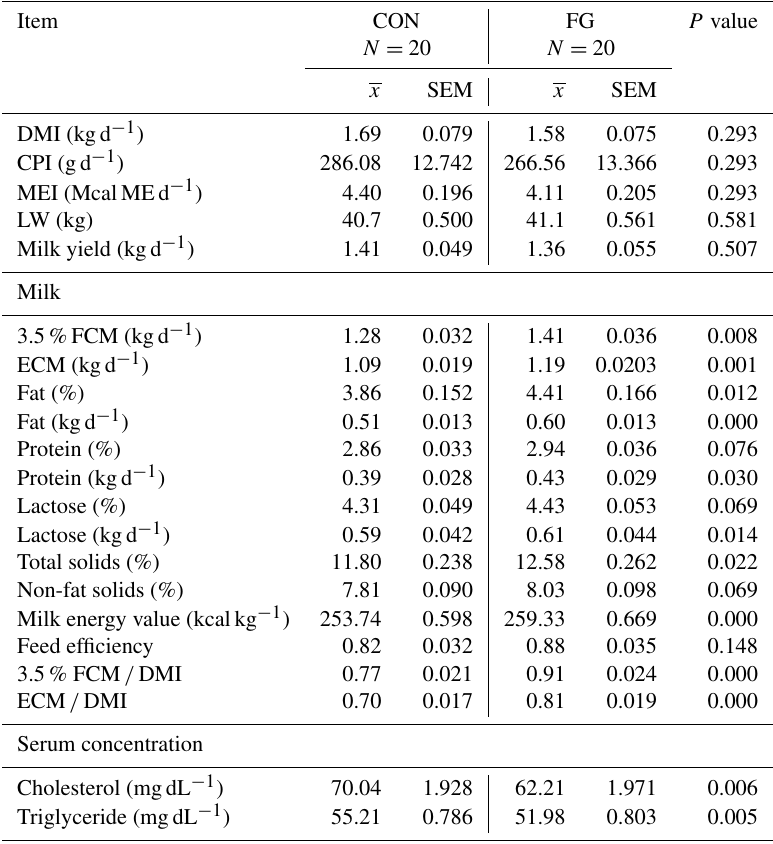
Table 3. The least squares mean ( x , LSM) and the standard error of the mean (SEM) for the effects of fenugreek supplementation on performance, milk composition, and serum parameters in goats.